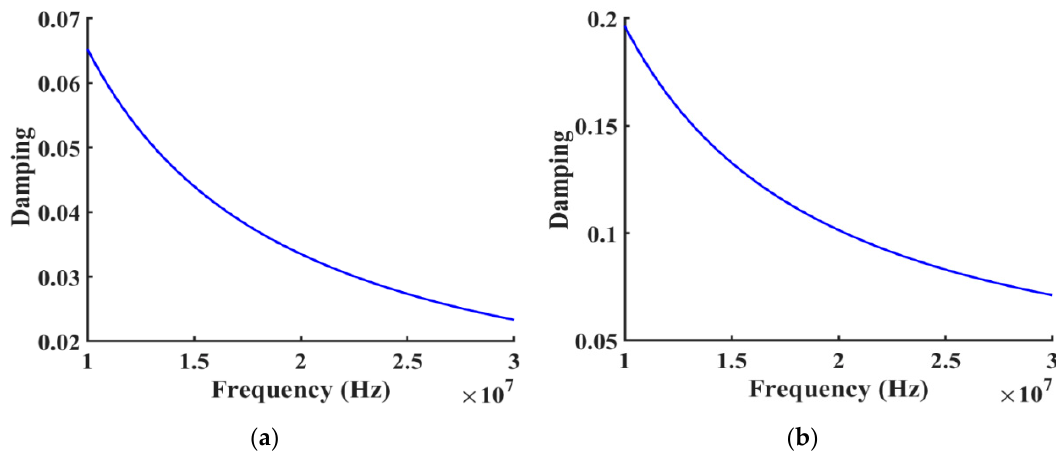
Figure 2. ( a ) The applied mechanical damping ratio in the substrate layer (lithium tantalate) at different frequencies. ( b ) The applied mechanical damping ratio in the IrO 2 layer at different frequencies.